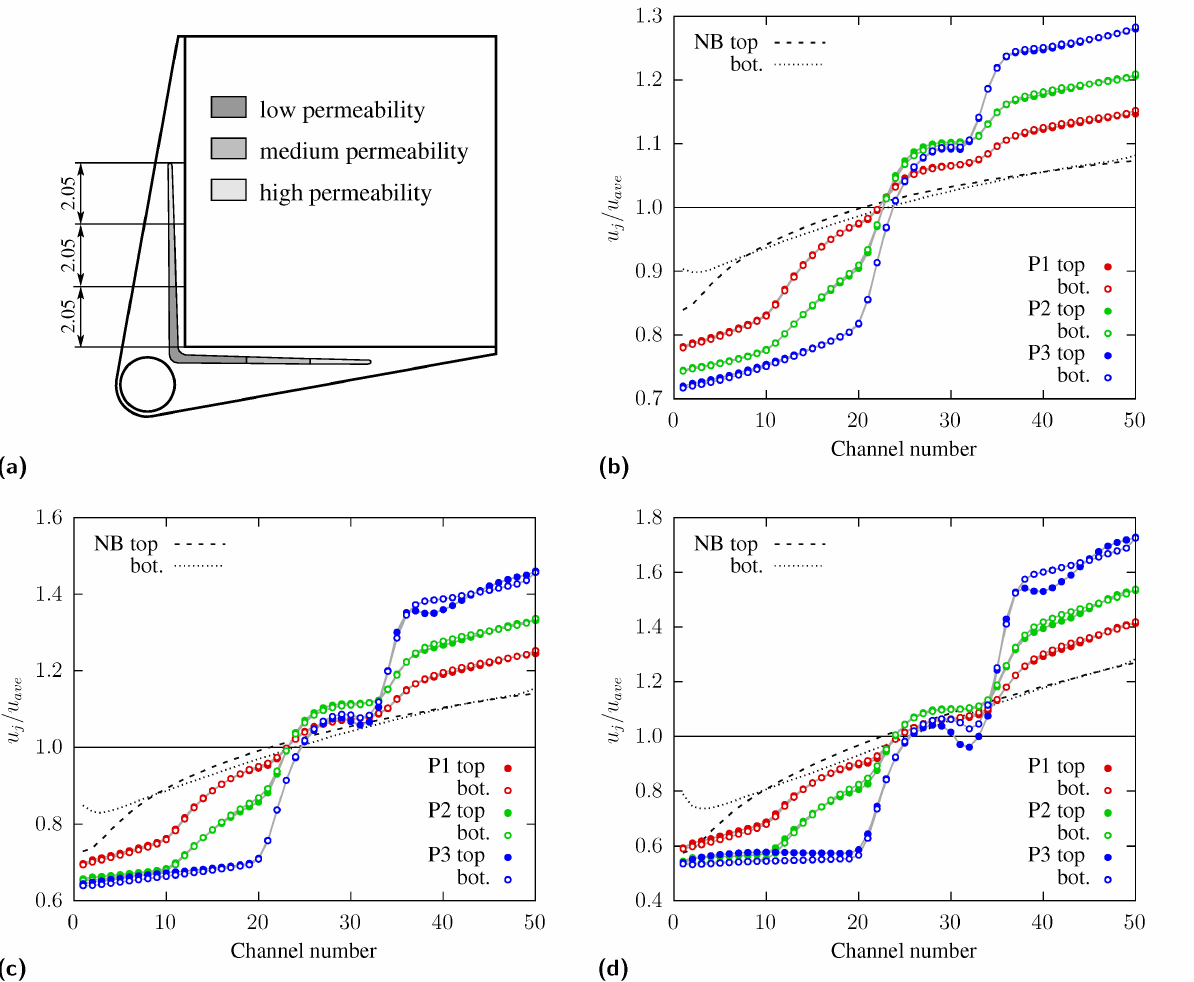
Figure 10. Header with porous baffle: ( a ) sketch of the inlet header and baffle with different porous sections; normalized velocity distributions for top and bottom layers obtained with different average velocities: ( b ) u ave = 0.5 m/s, ( c ) u ave = 1.0 m/s, ( d ) u ave = 2.0 m/s.